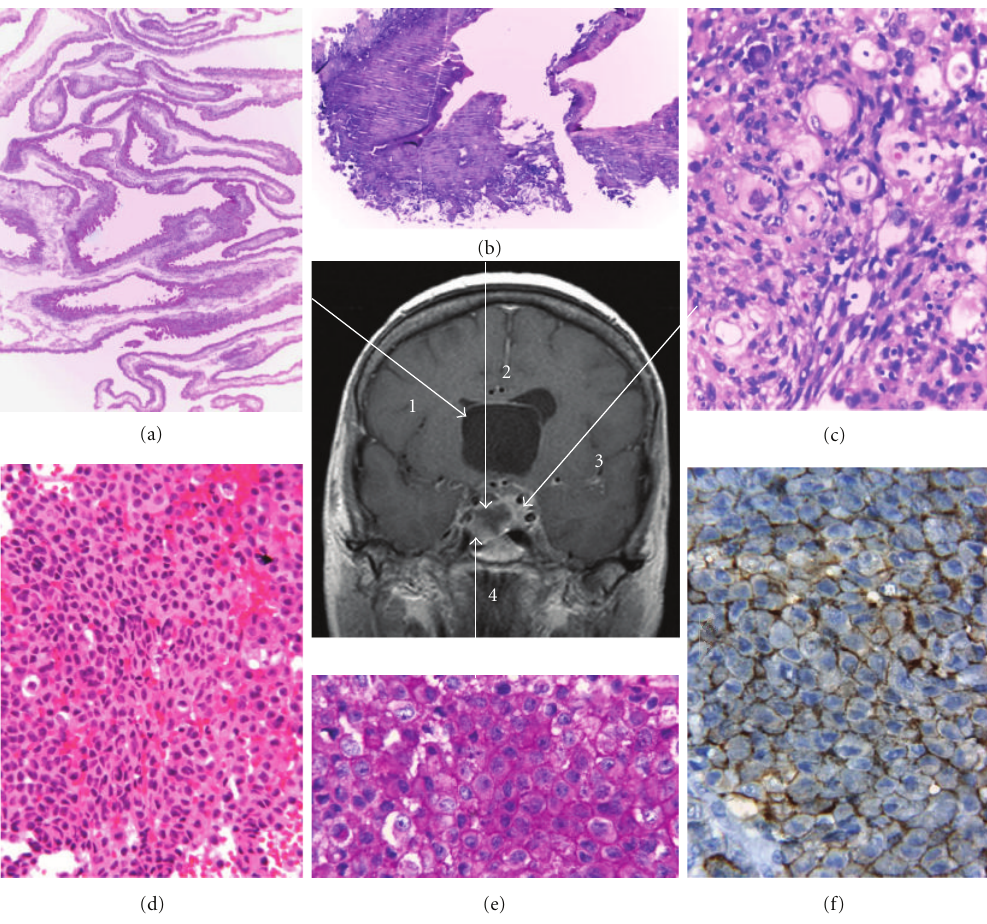
Figure 2: Correlation of MRI and pathological findings. Arrow 1: (a) viable cysticercus cyst (vesicular stage). H&E. Original magnification: 100x. Arrow 2: (b) nonviable cysticercus (granular and calcified stages). H&E. Original magnification: 100x. Arrow 3: (c) Psammomatous meningioma. H&E. Original magnification: 100x. Arrow 4: (d) pituitary adenoma. H&E. Original magnification: 250x; (e)